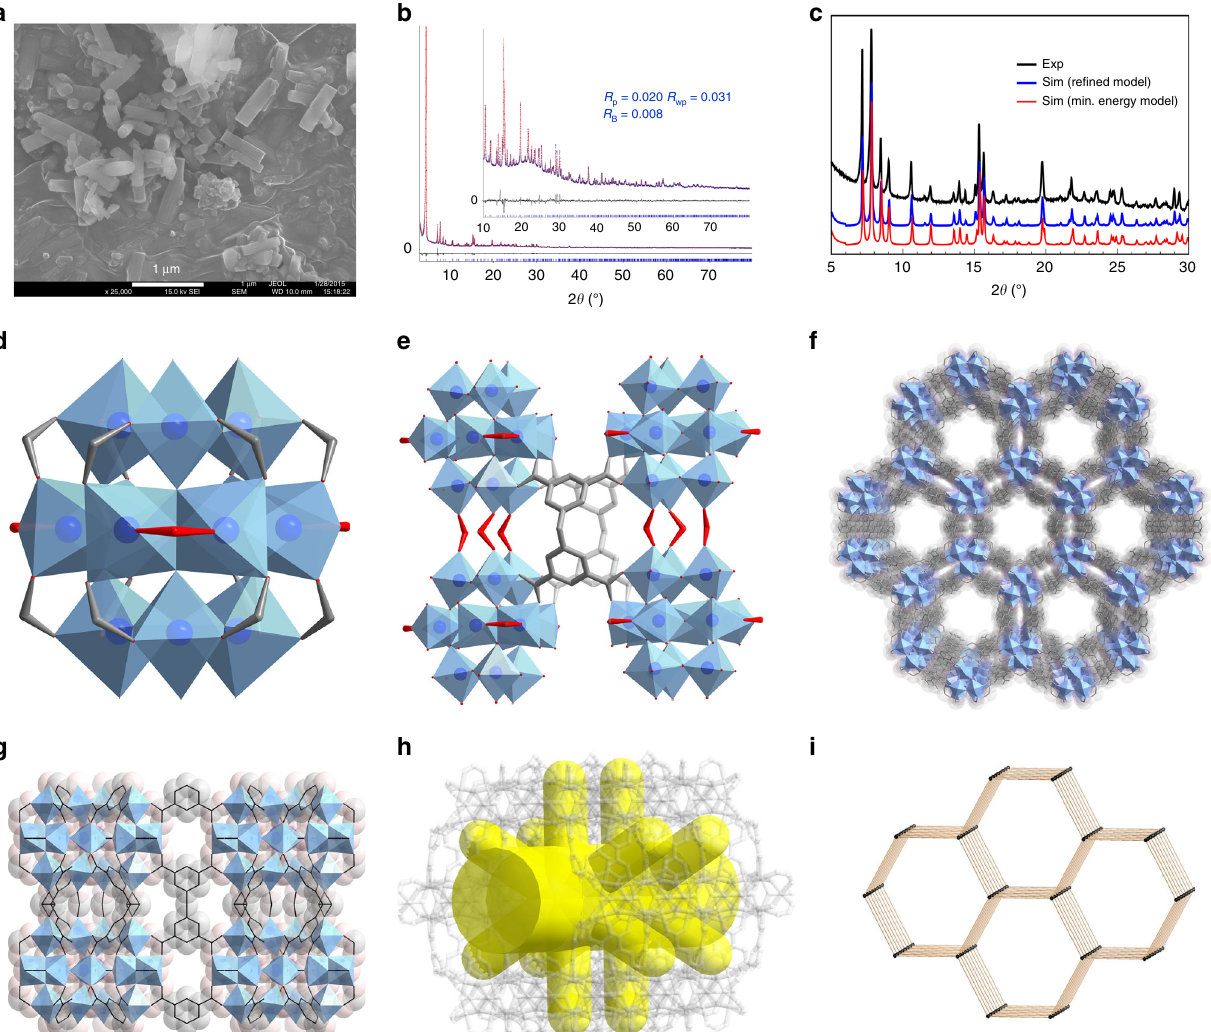
Fig. 2 Structural characterization and detail of MIL-177-LT. a SEM image of MIL-177-LT particles with a hexagonal rod morphology and a uniform size distribution. b Final Rietveld plot of MIL-177-LT structure. c Comparison of the PXRD patterns obtained from experimental data, theoretically derived minimum energy structure and re fi ned structure model of MIL-177-LT. d A Ti 12 O 15 cluster SBU with 12 carboxylate groups from mdip linkers (in gray) and terminal formate groups (in red). e Adjacent Ti 12 O 15 cluster SBUs with terminal and bridging formates (in red) connected by mdip linkers (in gray). f Nano- sized channels with a free diameter of 1.1 nm when viewed along the c -axis. g Small channels of 0.3 nm windows when viewed along the b -axis. h Overall pore shape of MIL-177-LT framework. i bnn topological network of